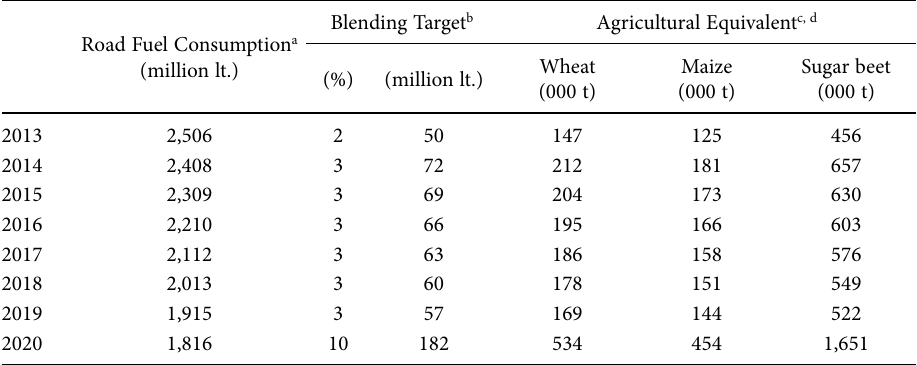
Table 1. Required bio-ethanol and agricultural raw product equivalents.